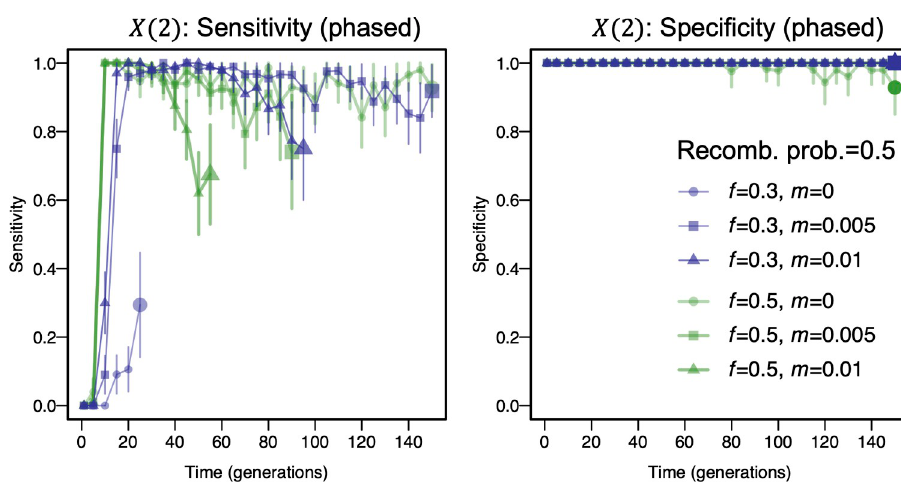
Fig 5. Sensitivity and specificity of negative X (2) for detecting a DMI, computed from 100 simulations of each parameter combination using SliM, assuming a Wright-Fisher population of 5000 individuals. We considered two admixture proportions, f = 0.5 and f = 0.3, and three migration rates from the minor parental population: 0, 0.01, and 0.05. A strong DMI ( α = 0.001, β = 0.002, γ = − 0.5) and no DMI ( α = 0.001, β = 0.002, γ = 0) were simulated under a Wright-Fisher model. The recombination probability between the DMI loci was c = 0.5. To exclude sampling noise, any interaction with X (2) < − 0.005& D ’ < 0 was taken as a putative DMI. Trajectories ended when one of the interacting loci became monomorphic (indicated by large plot markers). Three hundred individuals were sampled in each simulation. A. Sensitivity is high unless strong migration leads to swamping of the DMI alleles. B. Specificity is high under all tested scenarios when no DMI locus is present on the sampled chromosome. Vertical lines represent the 95% confidence interval (Wald test).